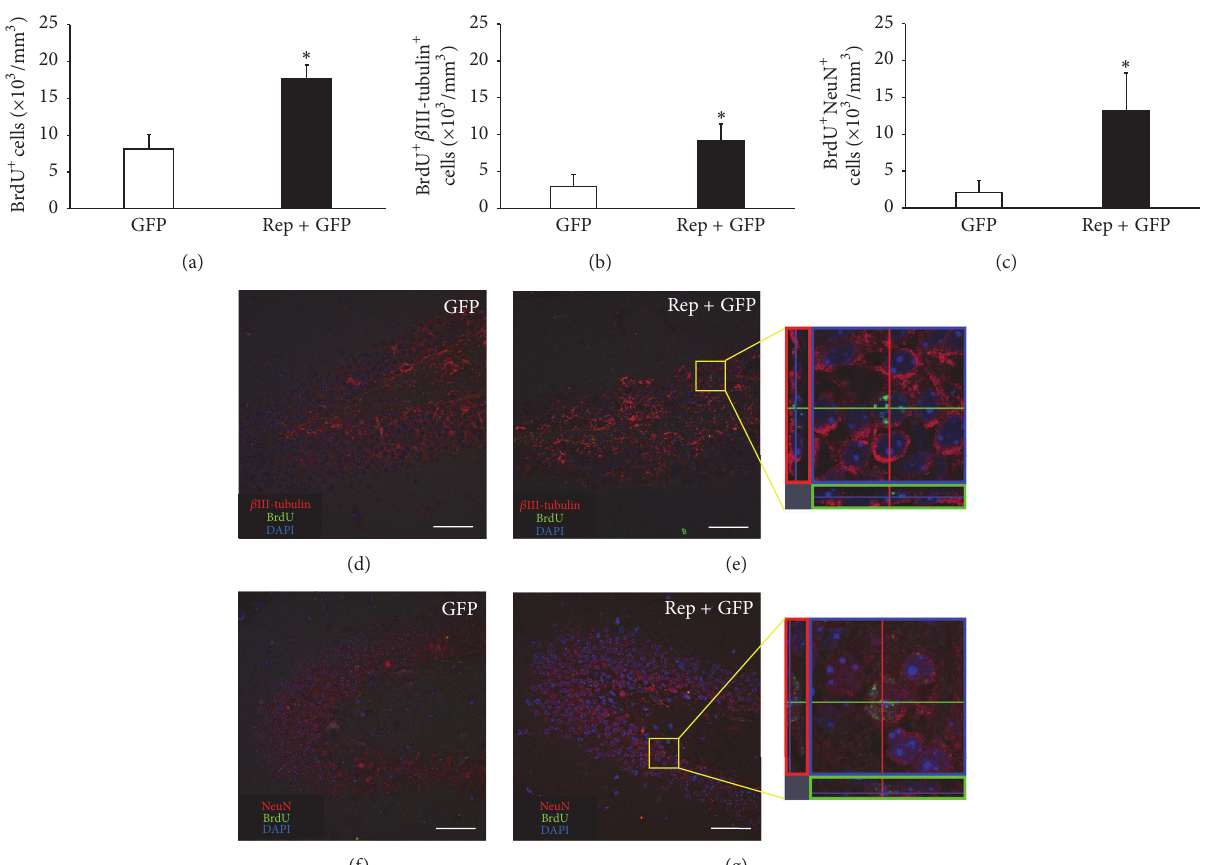
Figure 3: The number of new neurons in the hippocampus increased by in vivo expression of reprogramming factors. At postnatal 6 weeks, mice were injected with viral vector expressed GFP only (control group) or the four reprogramming factors and GFP (treatment group). To identify newly generated cells, mice were injected daily with 5-bromo-2-deoxyuridine (BrdU) up to 12 days. Eight weeks after injection, histological evaluations were performed. (a) The density of BrdU + cells in the hippocampus was significantly higher in the treatment group than in the control group ( 𝑡 = 3.528 , 𝑝 < 0.05 ). (b-c) The density of newly generated neurons was determined through confocal microscopy by calculating the density of cells triple positive for DAPI (blue, nuclei), BrdU (green), and cell type-specific markers such as 𝛽 III-tubulin and NeuN. The densities of BrdU + 𝛽 III-tubulin + (b) and BrdU + NeuN + (c) cells were significantly higher in the treatment group than the control group ( 𝑡 = 2.450 , 𝑝 < 0.05 and 𝑡 = 2.297 , 𝑝 < 0.05 , resp.). (d–g) Confocal microscope images are immunohistochemistry results. (e, g) Cells with triple positive for DAPI, BrdU, and cell type-specific markers are indicated in the yellow box at the right panel. Scale bars = 50 𝜇 m. ∗ 𝑝 < 0.05